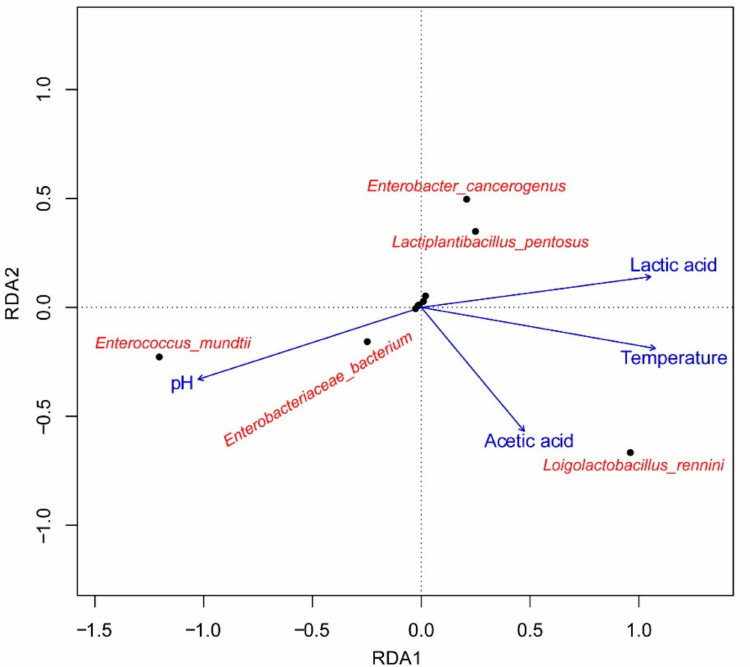
Figure 6. The redundancy analysis (RDA) analysis of high-throughput sequencing data related to the OTU level and major fermentation products. Five bacterial species showing most relationships with fermentation products were used in this